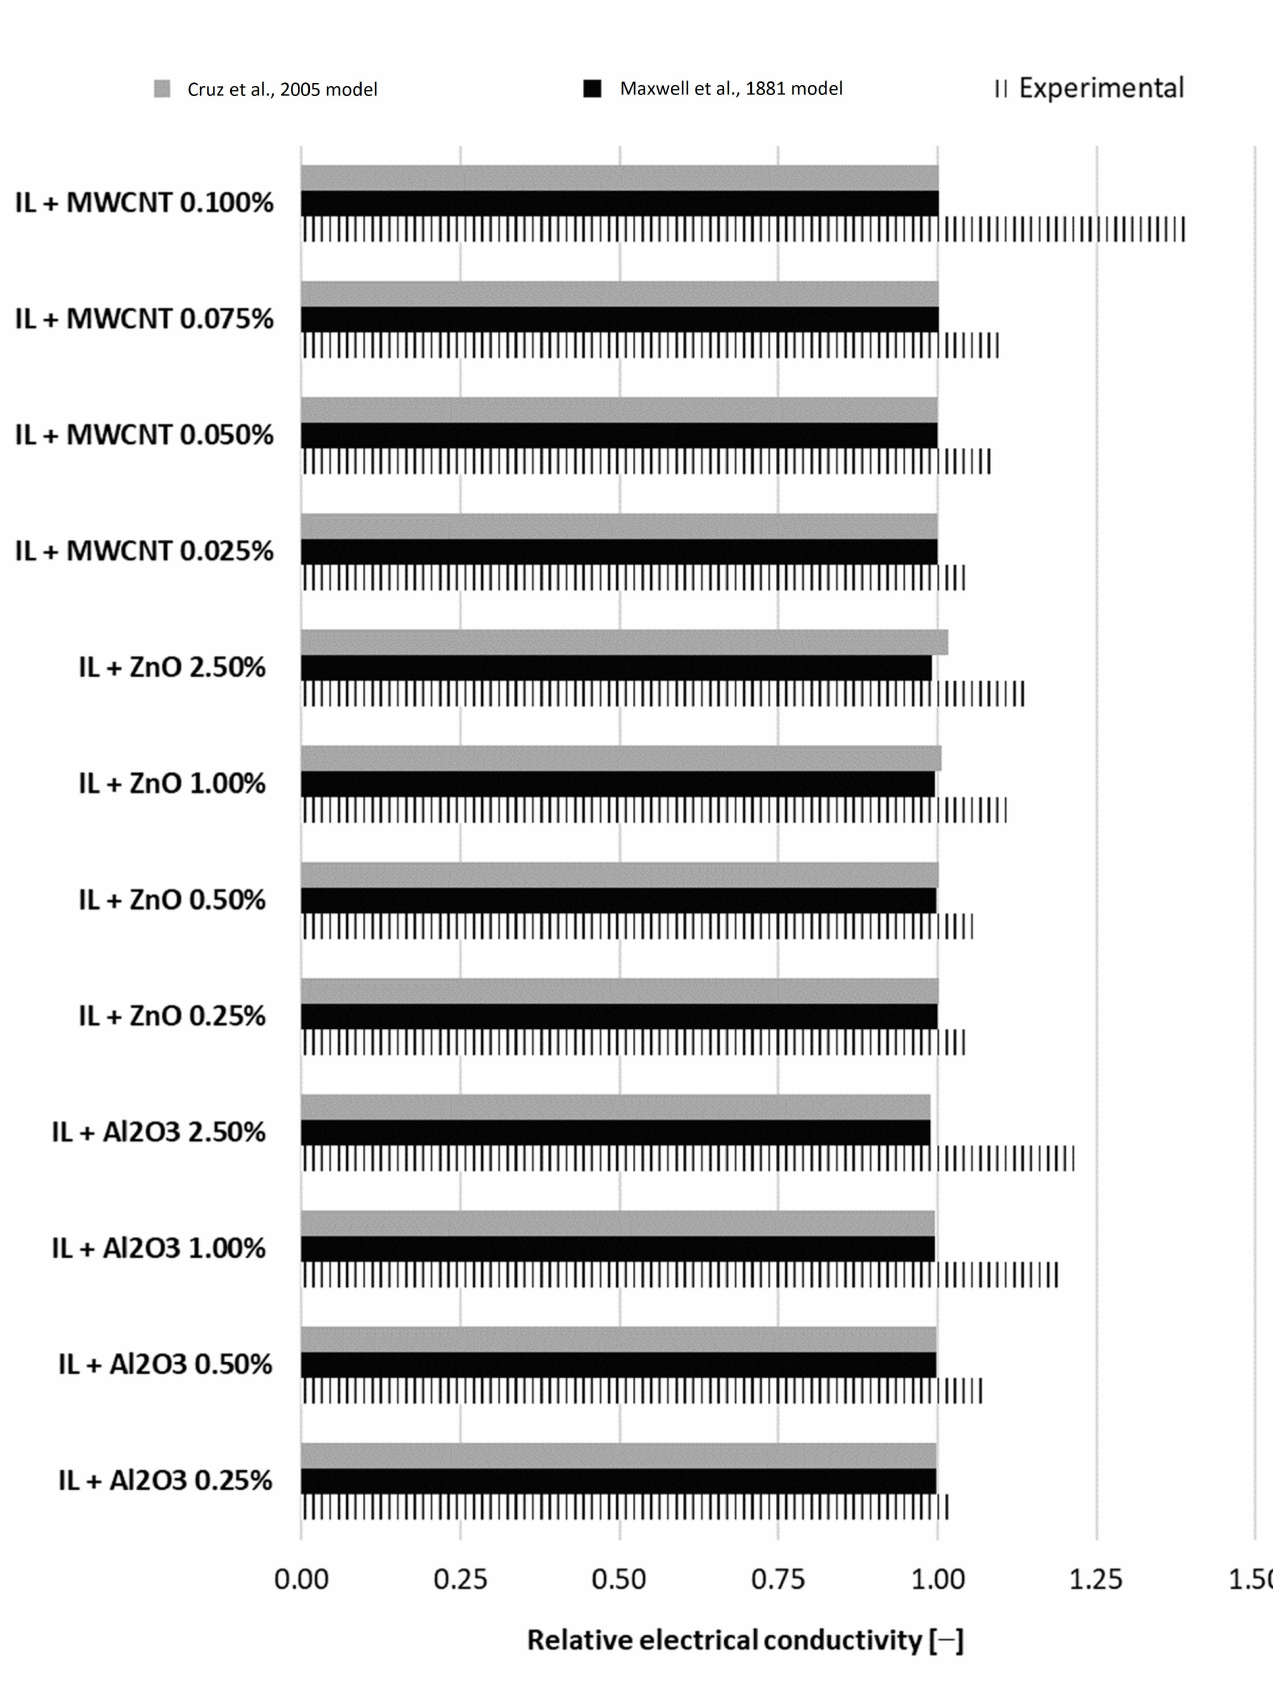
Figure 10. Experimental outcomes versus theoretical models